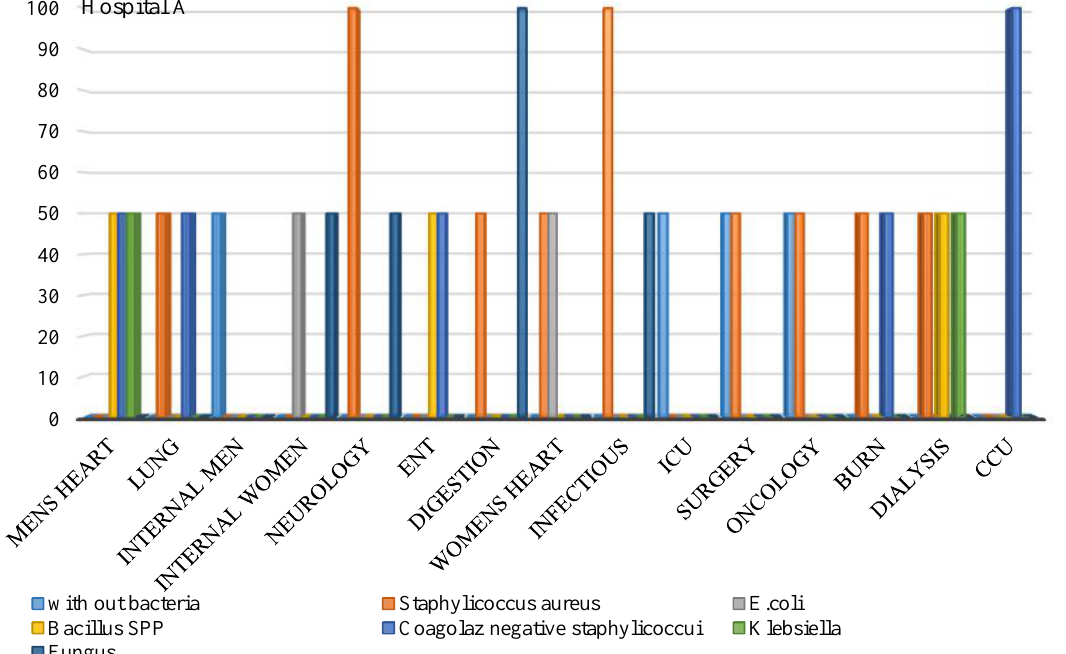
Fig. 3. Bacterial species frequency in different wards of hospital A after disinfection